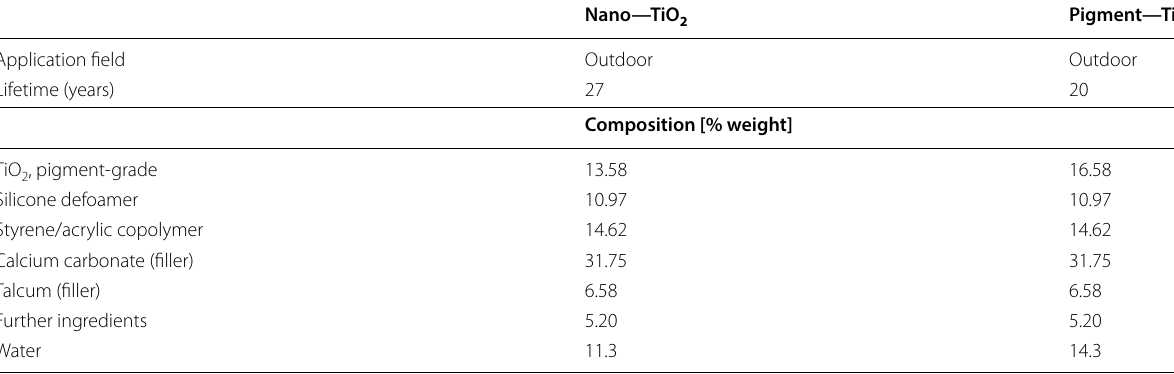
Table 1 Main characteristics of examined façade